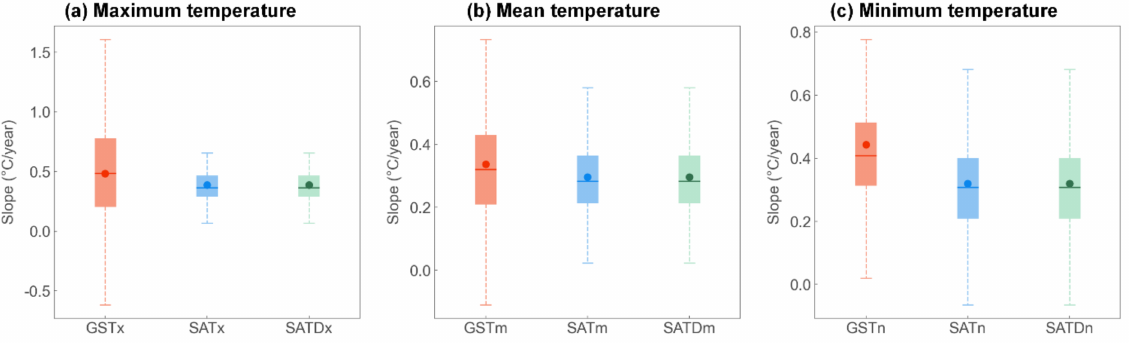
Figure 5. Box-and-whisker plots of trends in annual averaged GST-, SAT-, and SATD-related indexes from 1980–2019 in Southwest China ( a ) maximum temperature, ( b ) mean temperature, ( c ) minimum temperature (horizontal line represents median, and circle represents average).